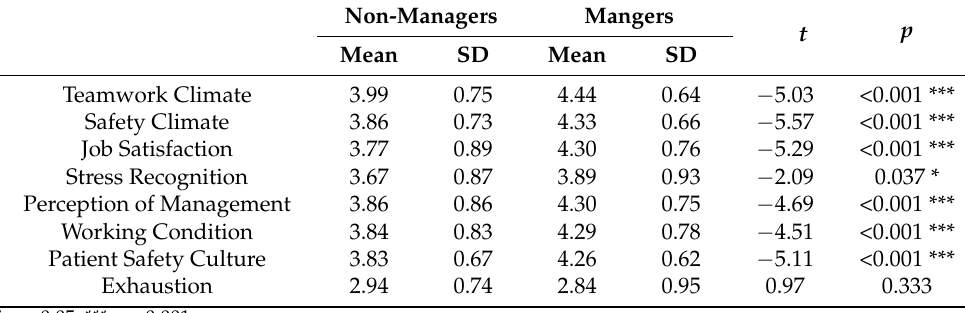
Table 4. Differences between means by managerial position.